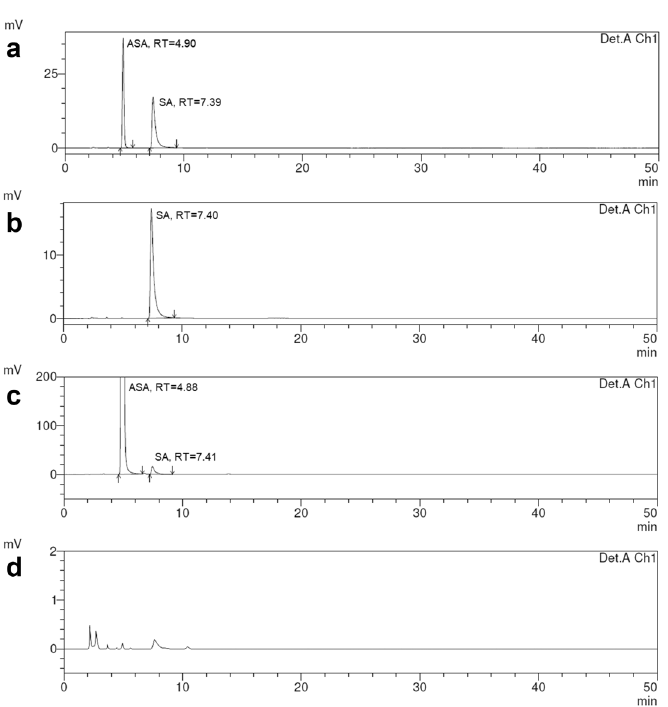
Figure 2. Exemplary chromatograms: ( a ) SSS solution, ( b ) reference solution, ( c ) solution containing reconstituted tablet (75 mg ASA, 40 mg GLY) spiked with salicylic acid at a concentration of 0.05% d) placebo of dosage 100 mg ASA and 40 mg GLY solution.